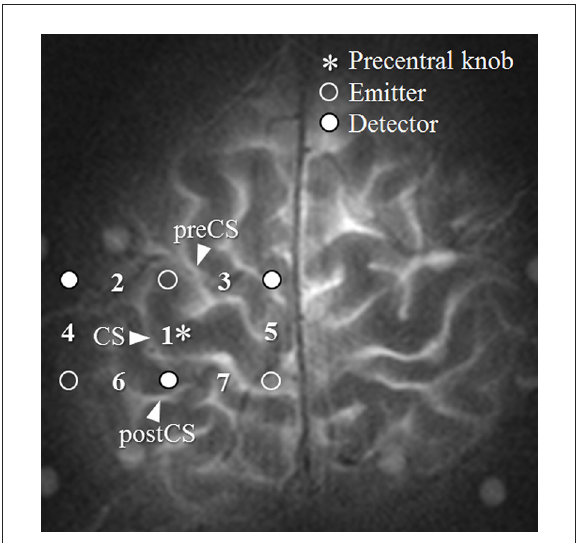
FIGURE1 Region of measurement. The numbers between the detectors and emitters are channel numbers. CS, central